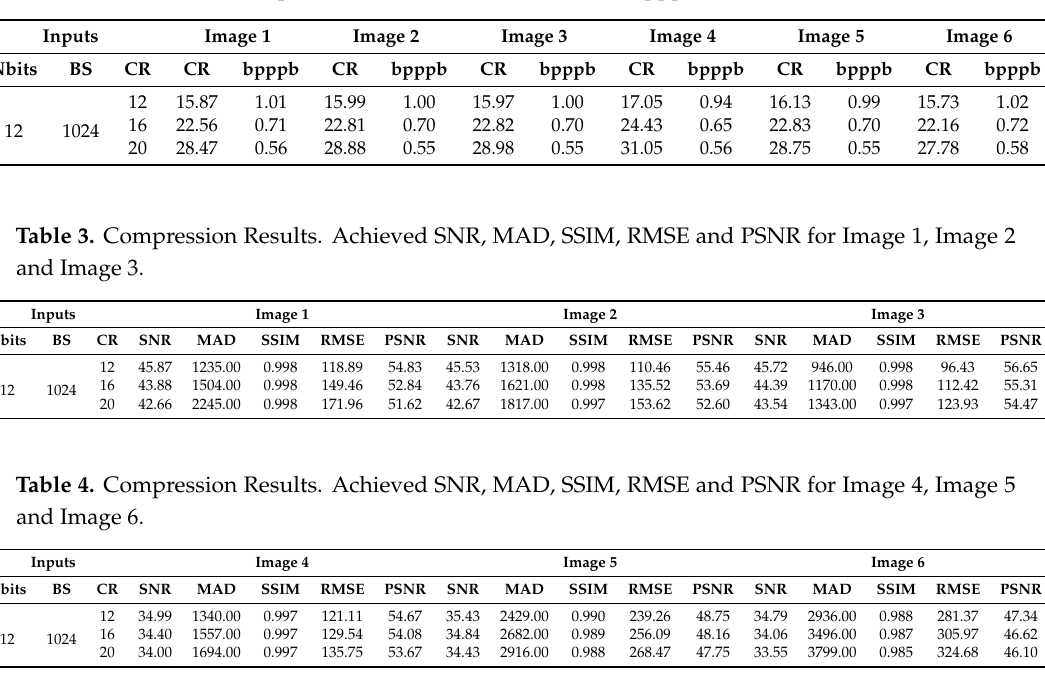
Table 2. Compression Results. Achieved CR and bppp for the six data sets.